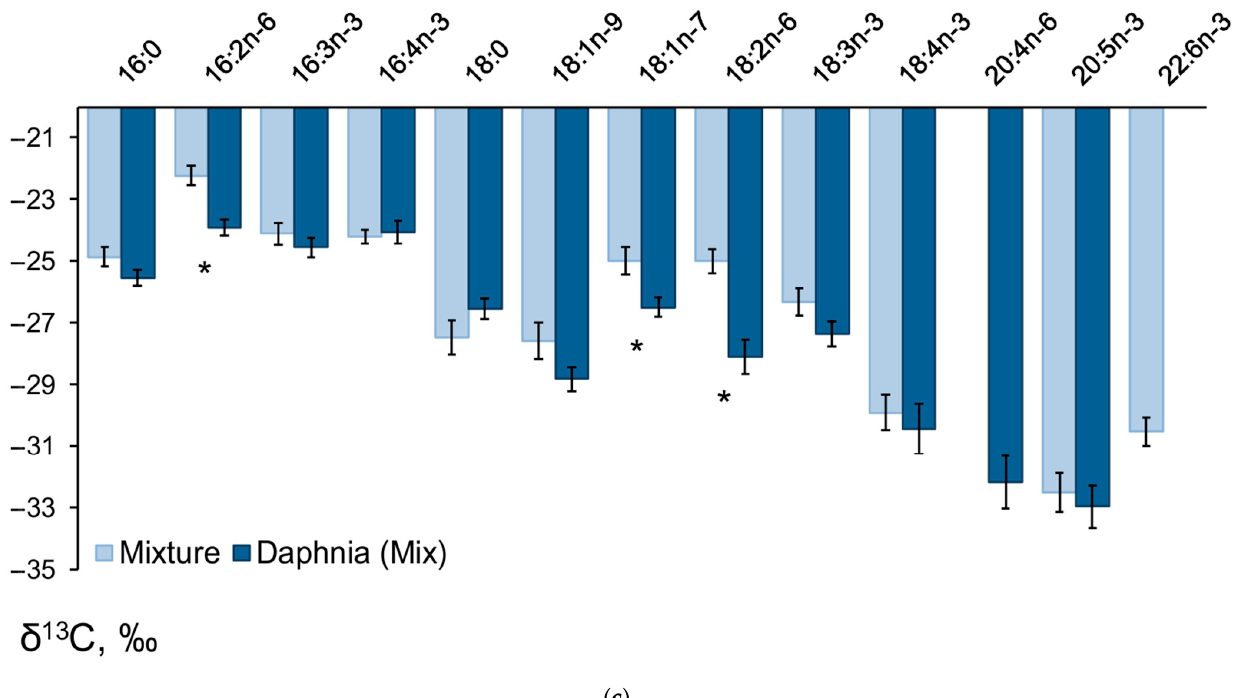
Figure 4. Average values of stable isotope values of FAs (± SE) in algae and in Daphnia galeata , fed ( a ) Chlorella vulgaris ; ( b ) Cryptomonas sp.; ( c ) the mixture of algae. Significant differences according to t -test ( p < 0.05) between algae and Daphnia are marked with *.